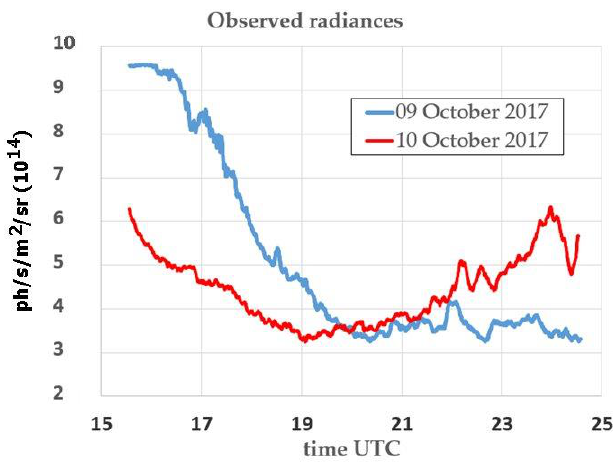
Figure 22. Time evolution of the mean radiance on the nights of 9 and 10 October 2017.